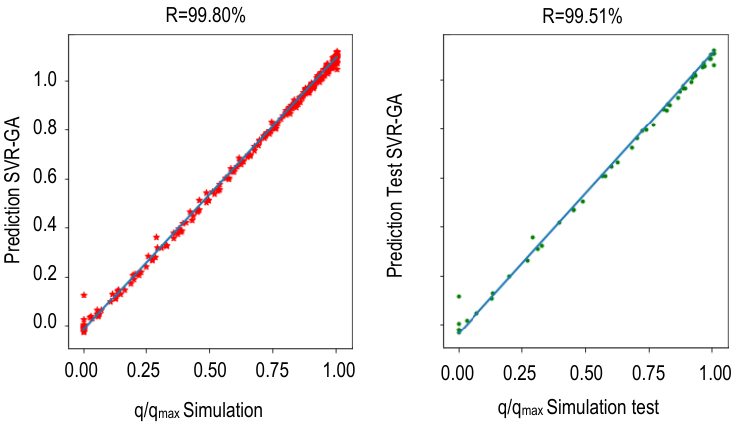
Figure 10. The correlation of R-Score of the SVR-GA model.